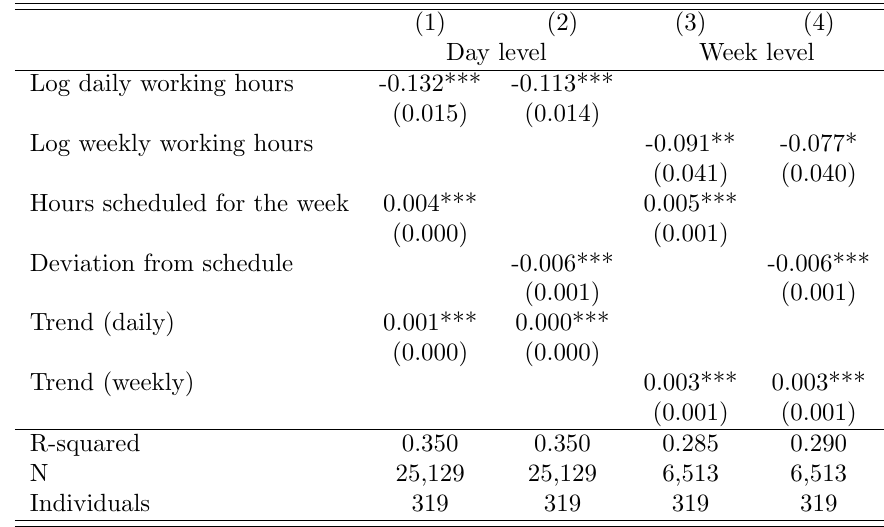
Table 9: Relationship between productivity and working time, controlling for weekly